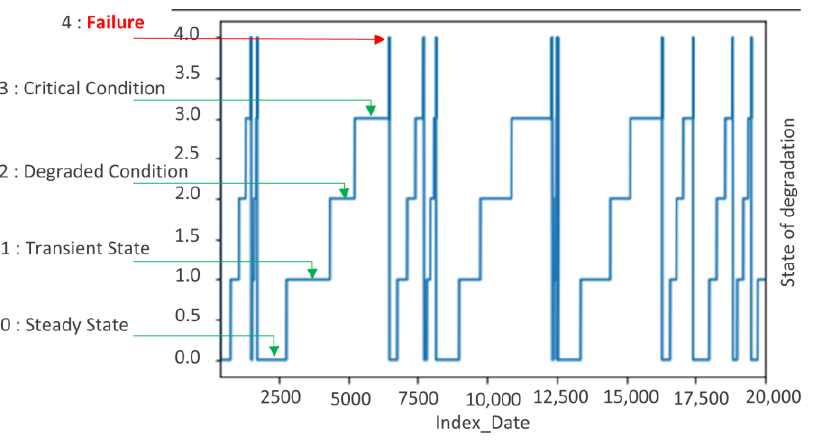
Figure 10. Degradation of the compressor condition.